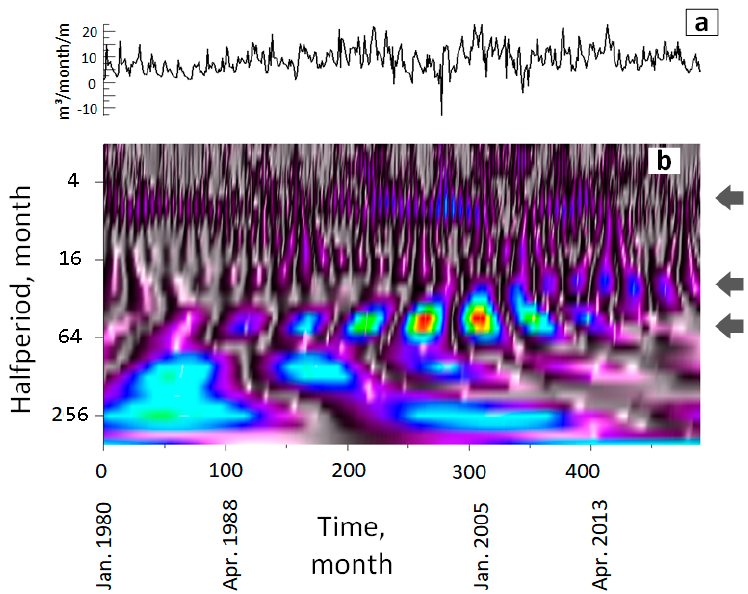
Figure 10. Wavelet-periodogram ( b ), based on the results of the calculated data (1980-2020) of the underground discharge (m 3 month − 1 m − 1 ) to the Southern Bug River ( a ). Distance between spots corresponds to half of the cycle. Cyclicity periods: top arrow—1 year, middle arrow—5–6 years, lower arrow—8 years.